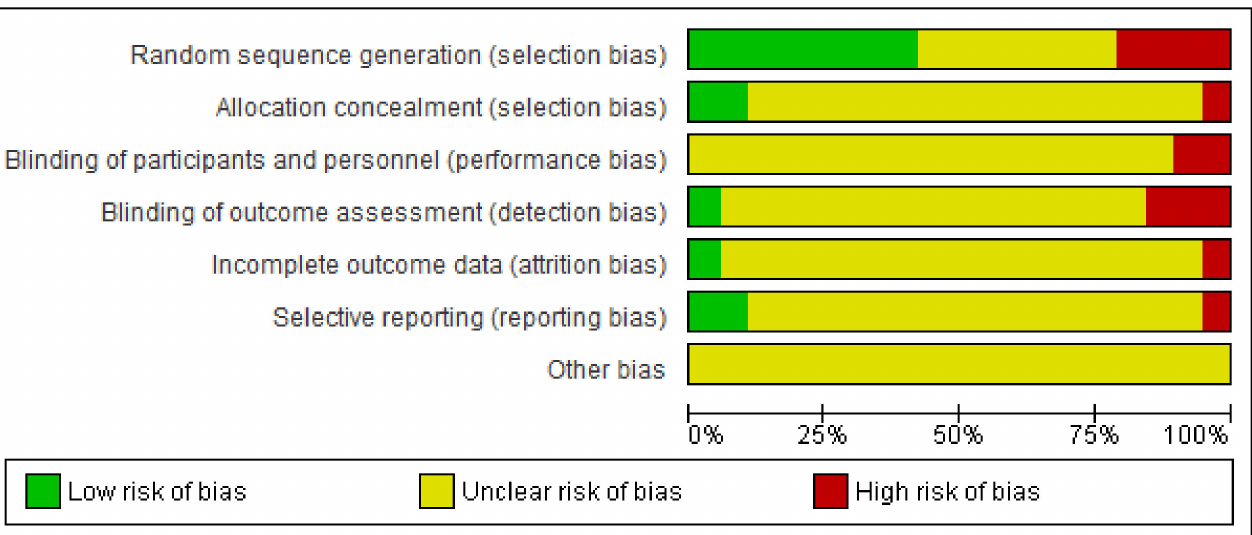
Figure 7. Risk of bias graph: review authors judgments about each risk of bias item presented as percentages across all included